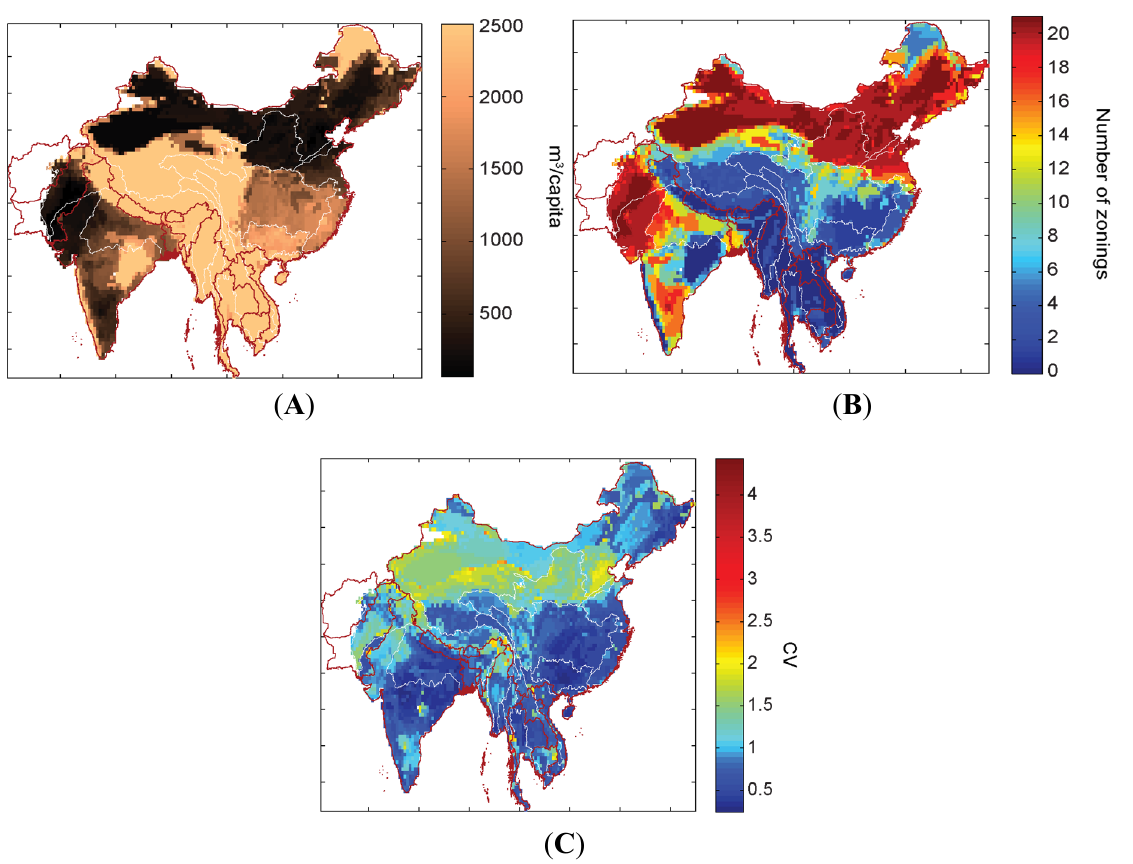
Figure 4. ( A ) Average water shortage per grid cell calculated based on the 21 zonings; ( B ) number of zonings under which the water shortage indicator value for grid cell was less than 1000 m 3 /cap/year; and ( C ) the coefficient of variation (CV) of water shortage indicator values per grid cell calculated over the 21